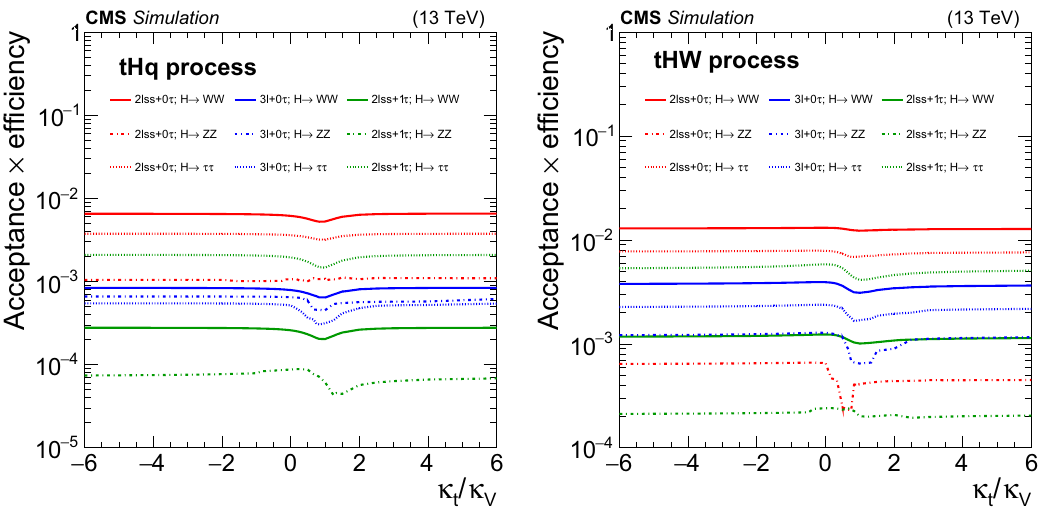
Fig. 16 Probability for tH signal events produced by the tHq (left) and tHW (right) production process to pass the event selection criteria for the 2 (cid:4) SS + 0 τ h , 3 (cid:4) + 0 τ h , and 2 (cid:4) SS + 1 τ h channels in each of the Higgs